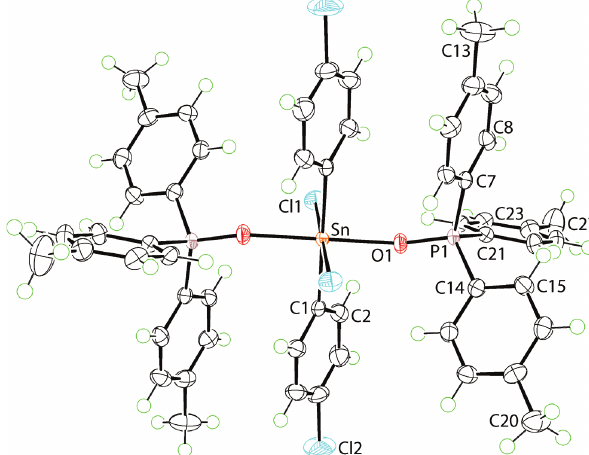
Table 2: Fractional atomic coordinates and isotropic or equivalent isotropic displacement parameters (Å 2